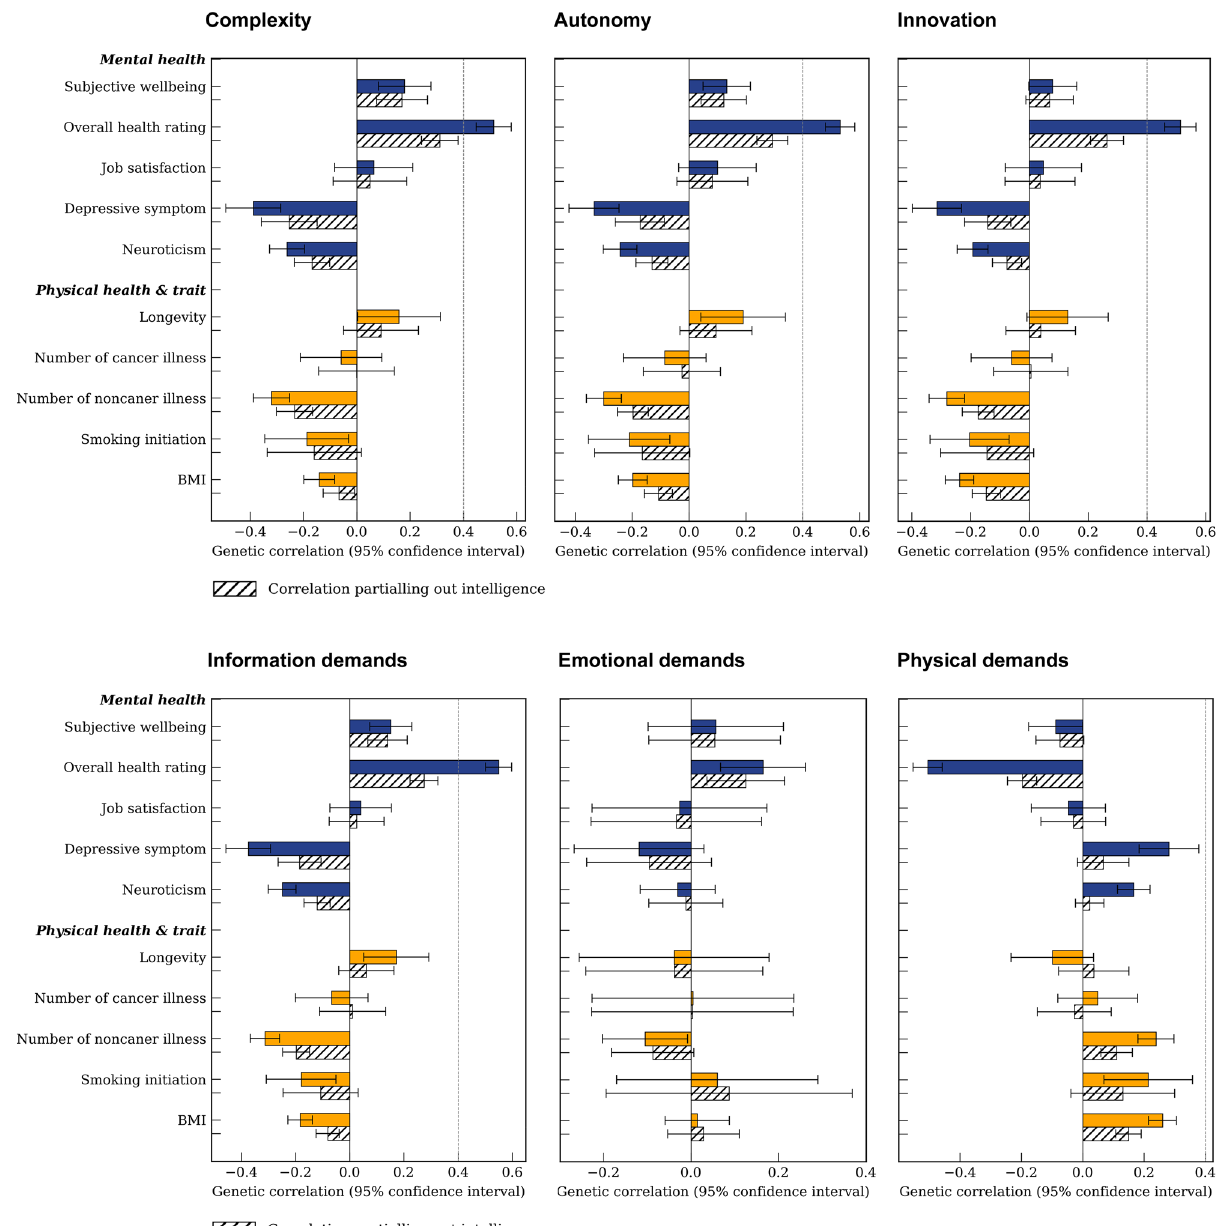
Figure 4. Genetic correlations of six job attainment characteristics with well-being. The x axis represents genetic correlation coefficients, and y axis labels each well-being trait. Coloured bars stand for genetic correlations before partialling out the genetic variance of intelligence, and grey shaded bars after partialling out the intelligence. Horizontal bars represent 95%